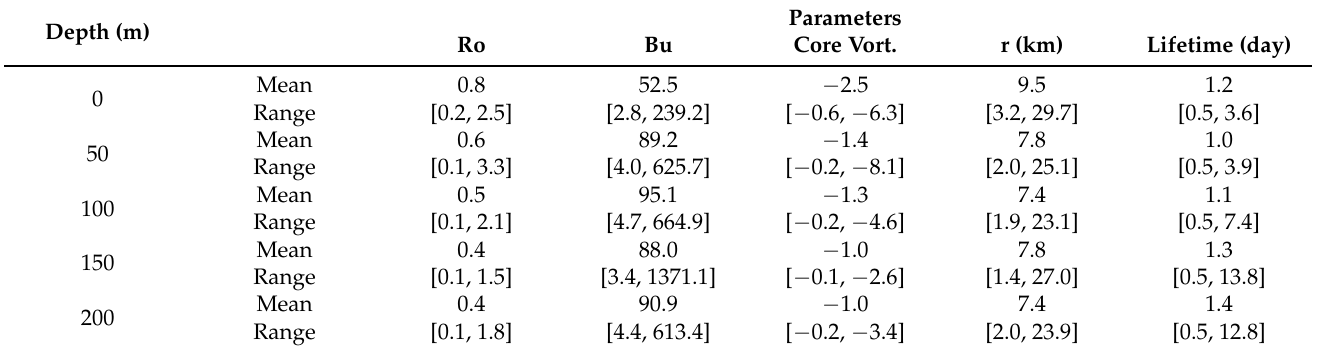
Table 2. The statistical results for parameters related to coherent AWEs detected from water depths of 0 m to 200 m based on the